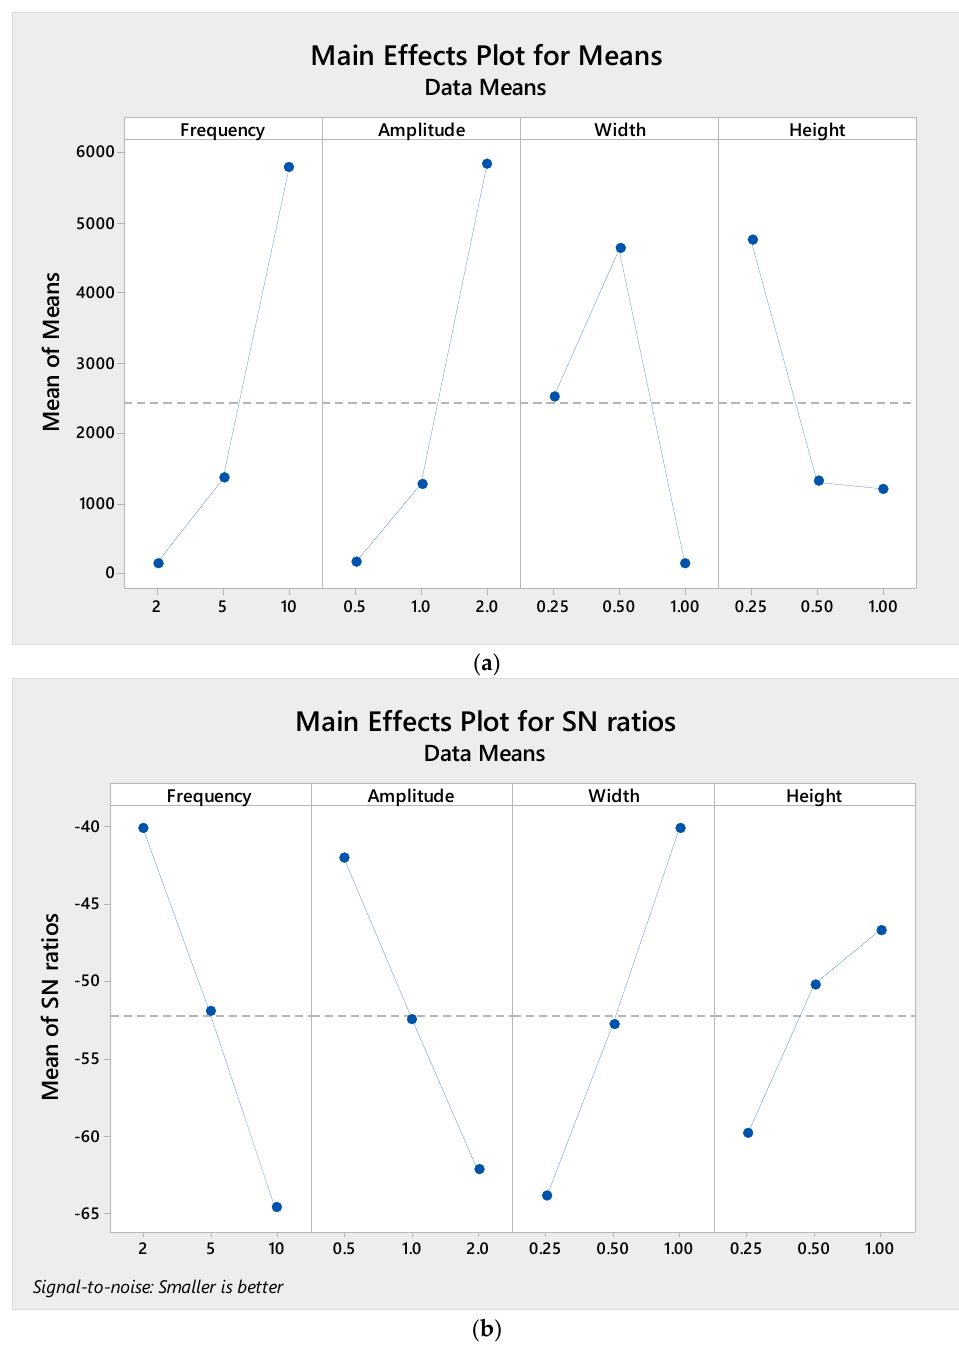
Figure 5 . Taguchi results of ( a ) Mean and ( b ) S/N response graph for pumping power. Figure 5. Taguchi results of ( a ) Mean and ( b ) S/N response graph for pumping